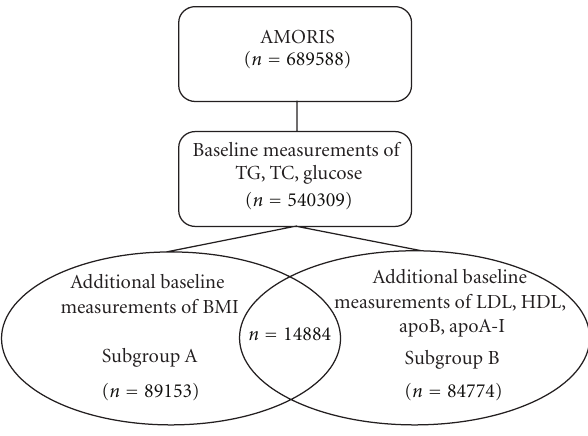
Figure 1: Overview of the study population.